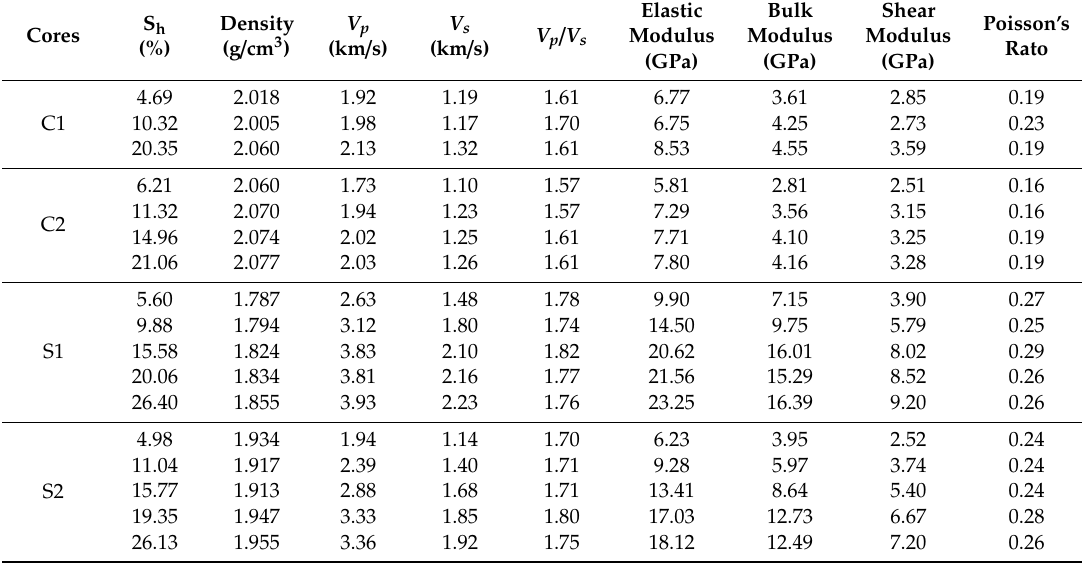
Table 2. Theacoustic parameters of hydrate-bearing sediments formed with natural recovered cores. Cores